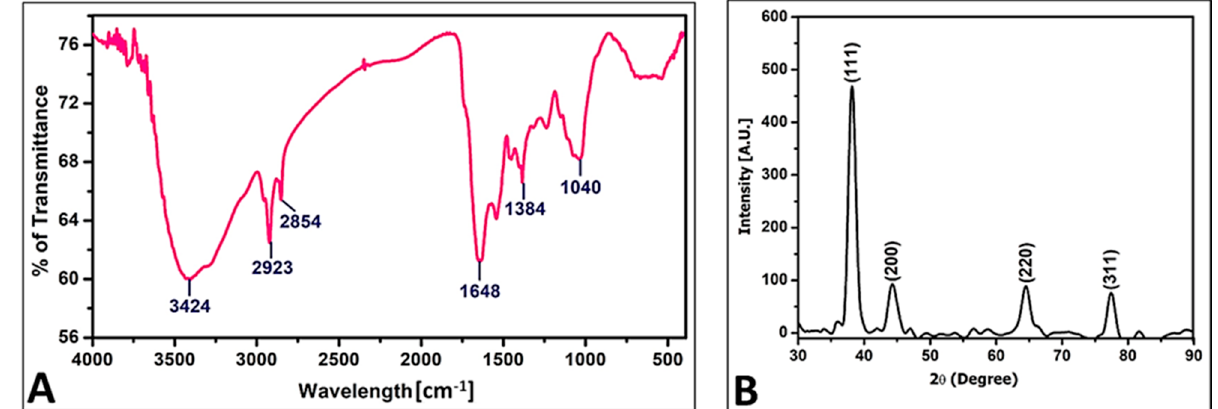
Figure 4. ( a ) FT-IR analysis of PoAgNPs. ( b ) XRD of PoAgNPs. Figure 4. ( A ) FT-IR analysis of PoAgNPs. ( B ) XRD of